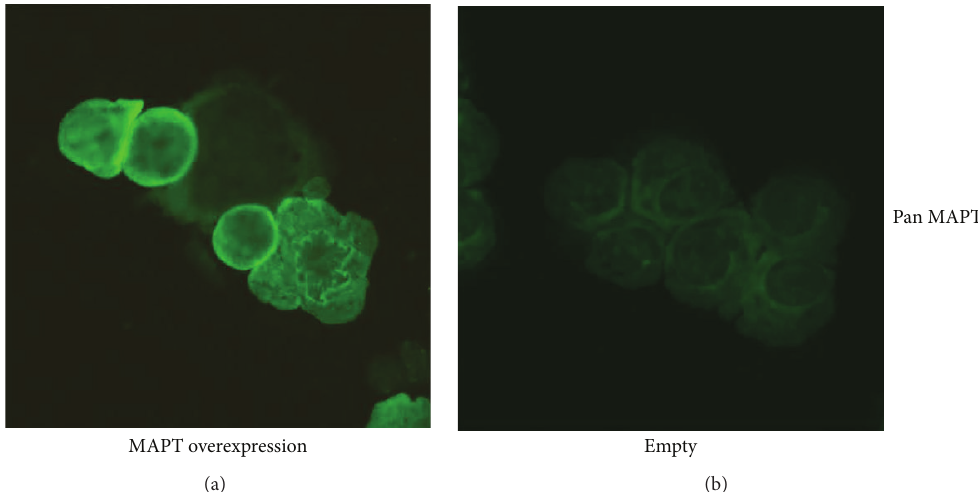
Figure 4: Confocal immunofluorescence staining of Rin-5F cell lines. MAPT overexpressing cell line (a) and Empty (b) stained by the pan MAPT specific Ab followed by Alexa Fluor goat anti-rabbit Ab. Images were taken by Axiovert confocal microscope 200 M (Zeiss Jena, Germany).